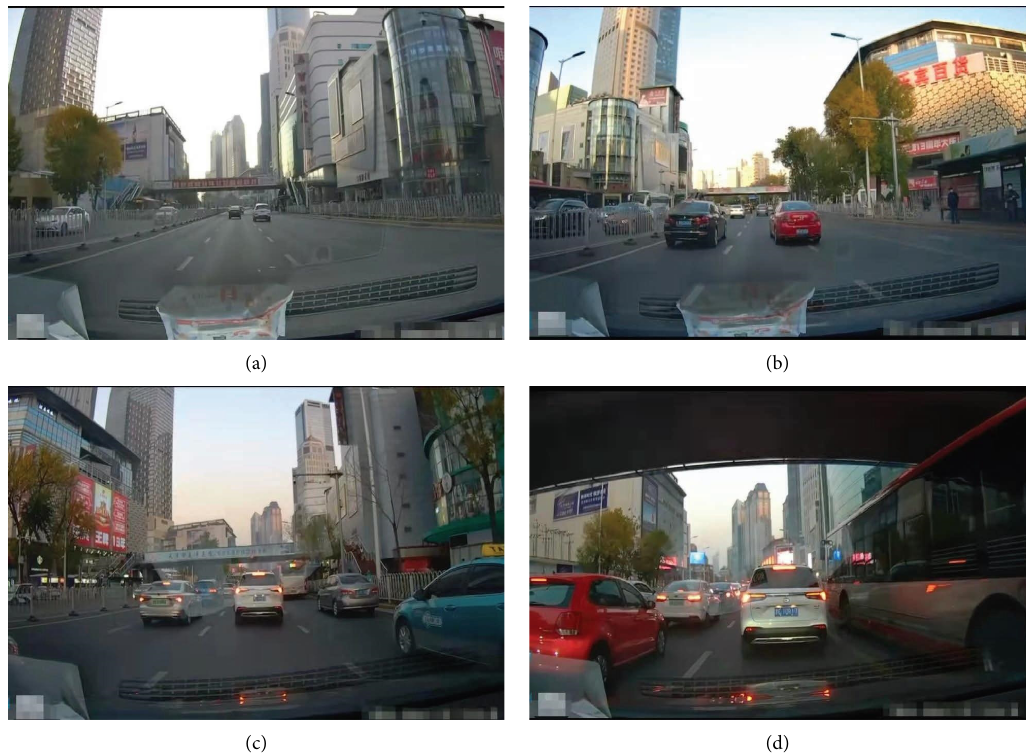
Figure 2: Trafc fow status of diferent congestion levels: (a) smooth, (b) mild congestion, (c) moderate congestion, and (d) serious